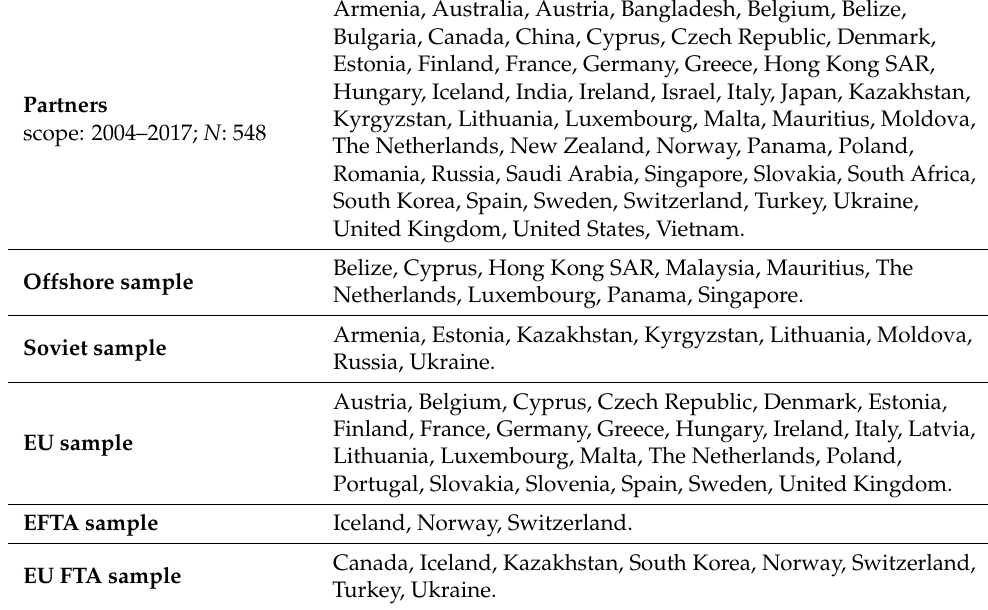
Table A1. List of inward FDI partners for Latvia.